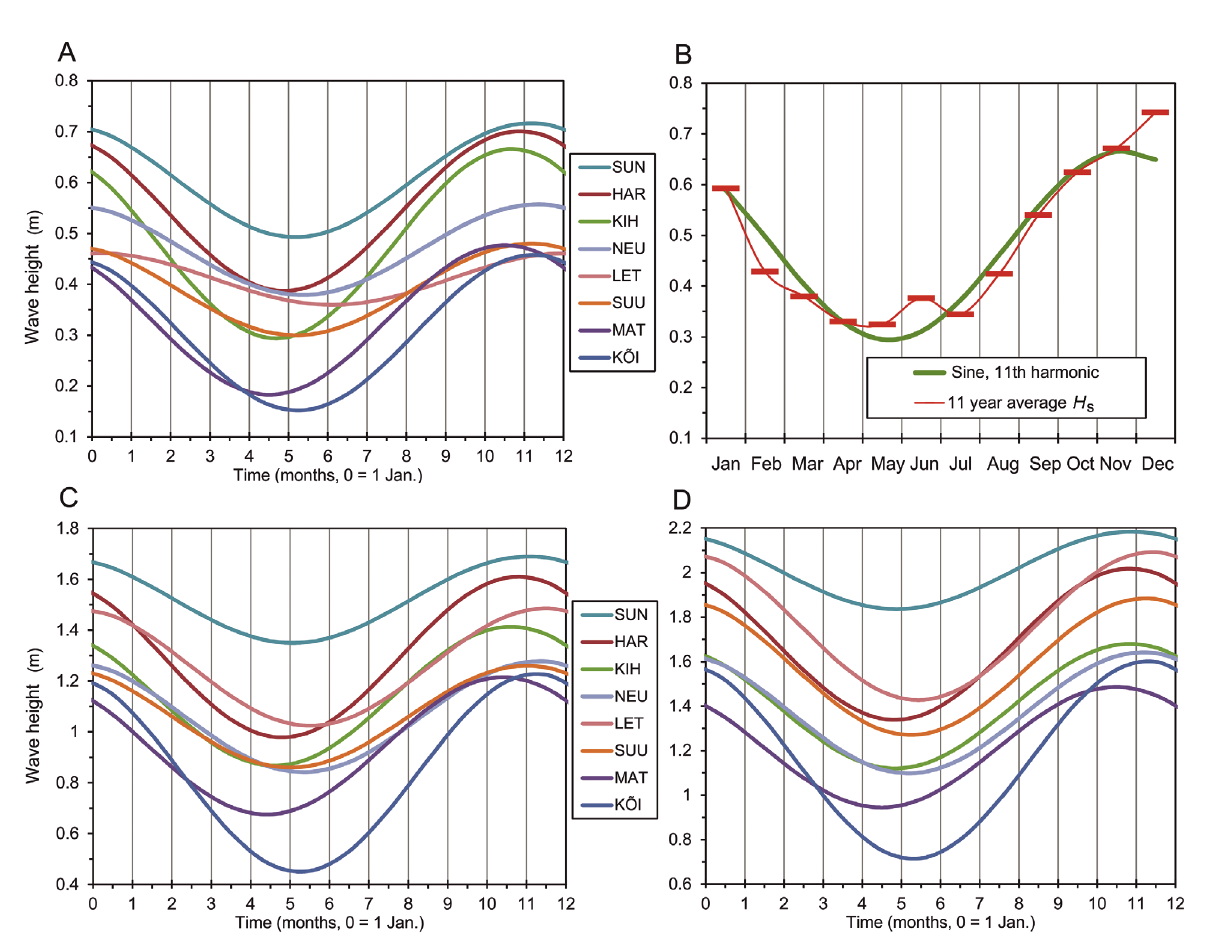
Fig. 5. Idealized seasonal variations (expressed as a single sine) of average wave conditions ( A ), 95th ( C ) and 99th ( D ) percentiles. Comparison between the seasonal harmonic and monthly averages at Kihnu ( B ). See Table 2 for the exact parameters and Table 1 for codes of the